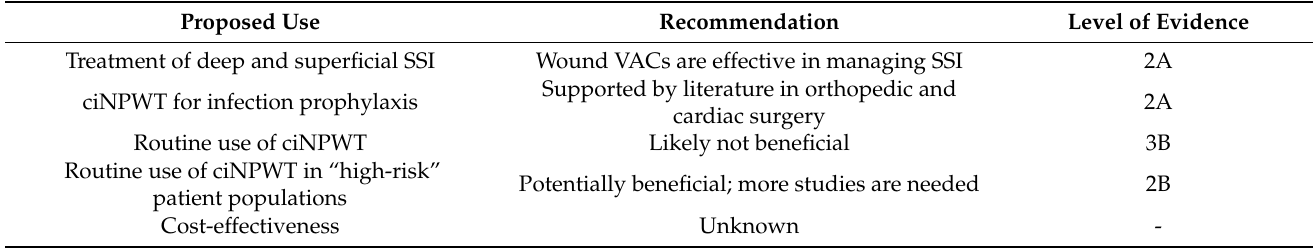
Table 2. Summary of Recommendations for the use of NPWT in Spinal